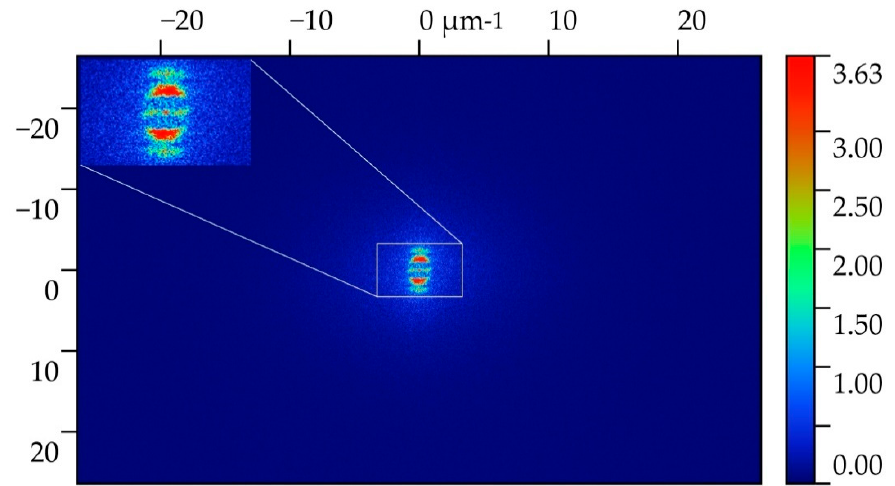
Figure 2. Representative 2D-FT of the image shown in Figure 1a. Inset: detailed view of the central part. Intensity scale (bar on the right) is in arbitrary units.